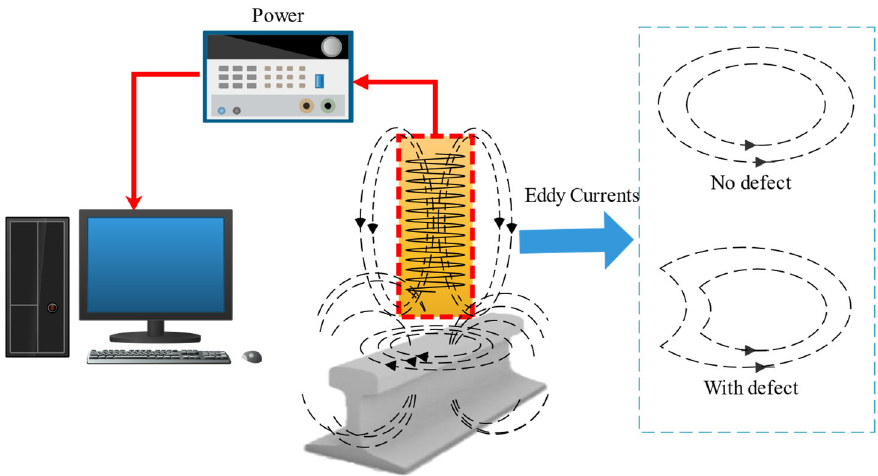
Figure 3. Eddy current inspection for